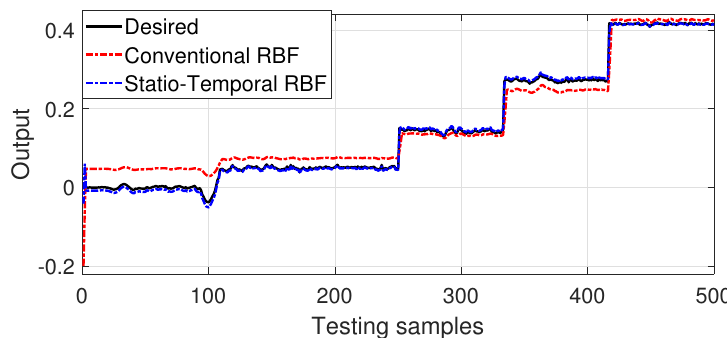
Figure 6. Prediction results of ST − RBF and conventional RBF.